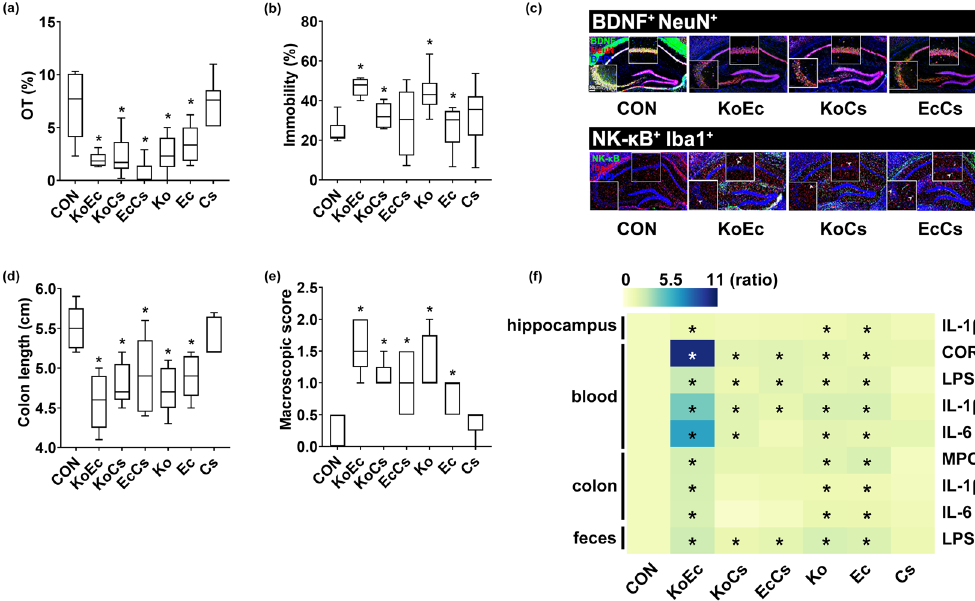
Figure 4. Combined effects of two bacteria belonging to Enterobacteriaceae on the occurrence of anxiety/ depression and colitis in mice. Effects on the occurrence of anxiety/depression in the EPMT ( a ) and TST ( b ). Effects on the BDNF + /NeuN + and NF-κB + /Iba1 + cell population in the hippocampus ( c ). Effects on the colon length ( d ) and macroscopic score ( e ). ( f ) Effects on the IL-1β, IL-6, LPS, MPO, and corticosterone levels, indicated as compared to control group (CON: 1). Heatmap was generated using Plotly (https:// chart- studio. plotly. com). Among Klebsiella oxytoca (Ko), Escherichia coli (Ec), and Cronobacter sakazakii (Cs), two bacterial (KoEc, 1:1 of KO and Ec; KoCs, 1:1 of Ko and Cs; EcCS, 1:1 of Ec and Cs) combinations at a dose of 1 × 10 8 CFU/mouse/day were orally gavaged once a day for 5 days in mice. Control mice were treated with vehicle (saline) instead of gut bacterial suspension. Data are shown as box plots (n = 6). *p < 0.05 vs Con. All were analyzed using unpaired t